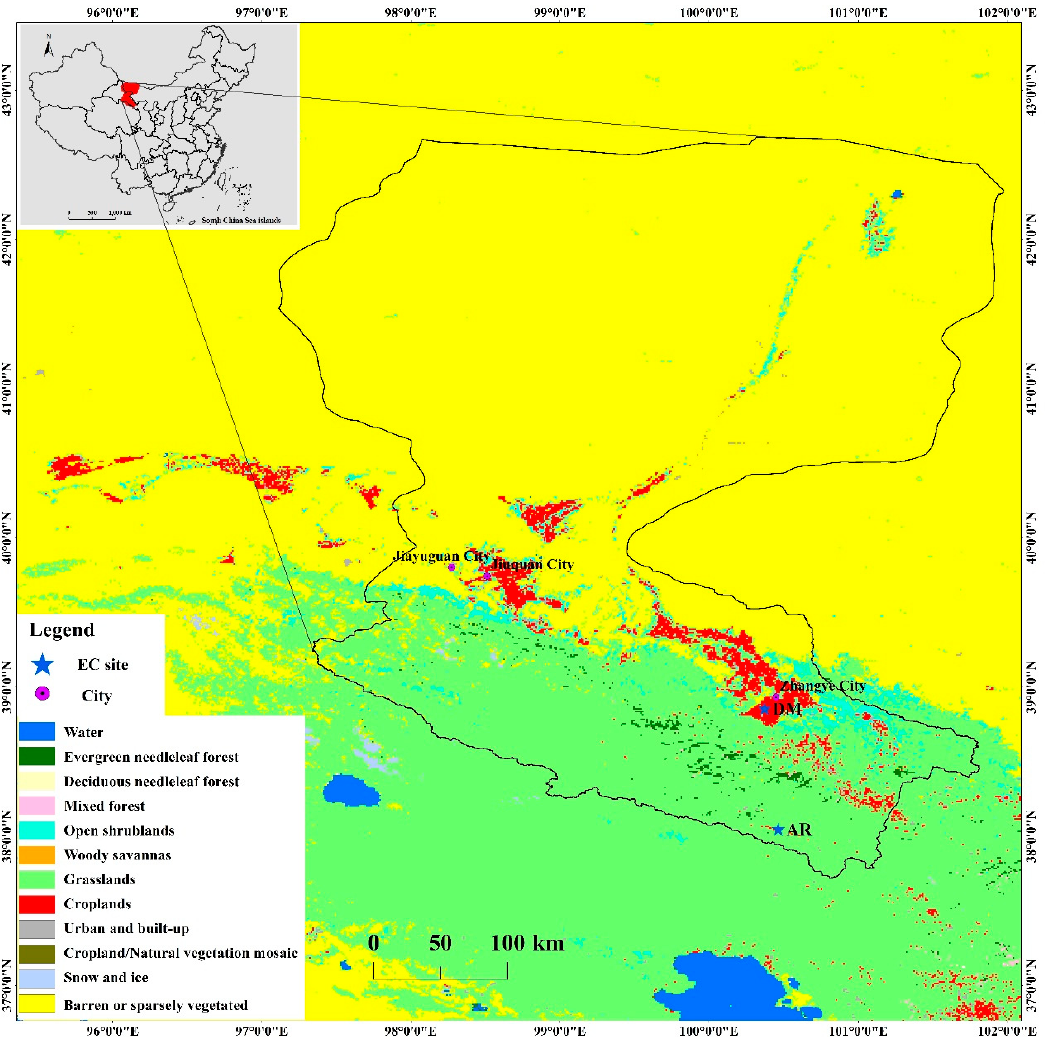
Figure 1. Locations of the study sites. (background land cover map is from the MODIS Land Cover Type product MCD12Q1, which is based on the University of Maryland land cover classification scheme).